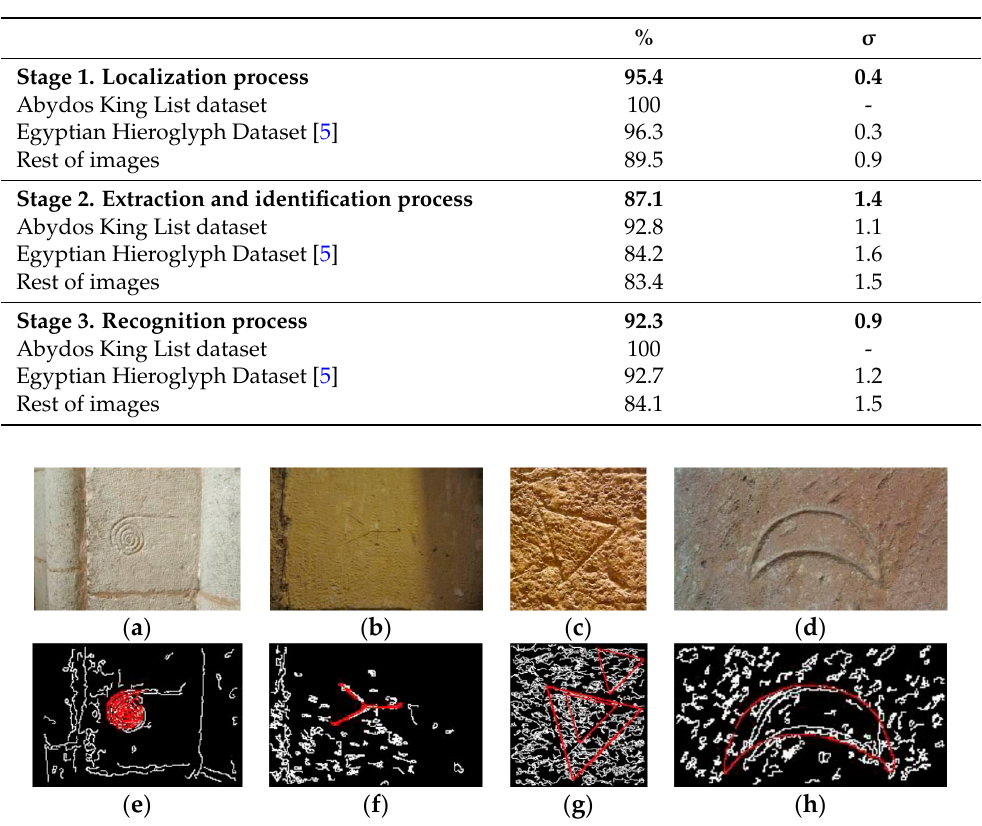
Figure 13. The location process applied to search for stonemason’s marks: ( a – d ) original images; ( e – h ) localization process